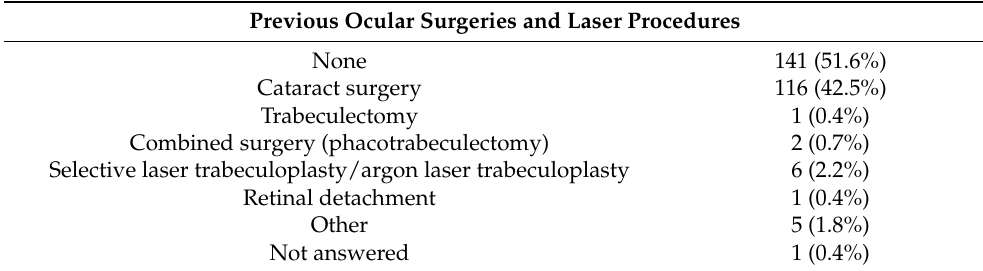
Table 4. Previous ocular surgeries and laser procedures of the patients enrolled in the XEN-GTR (no.